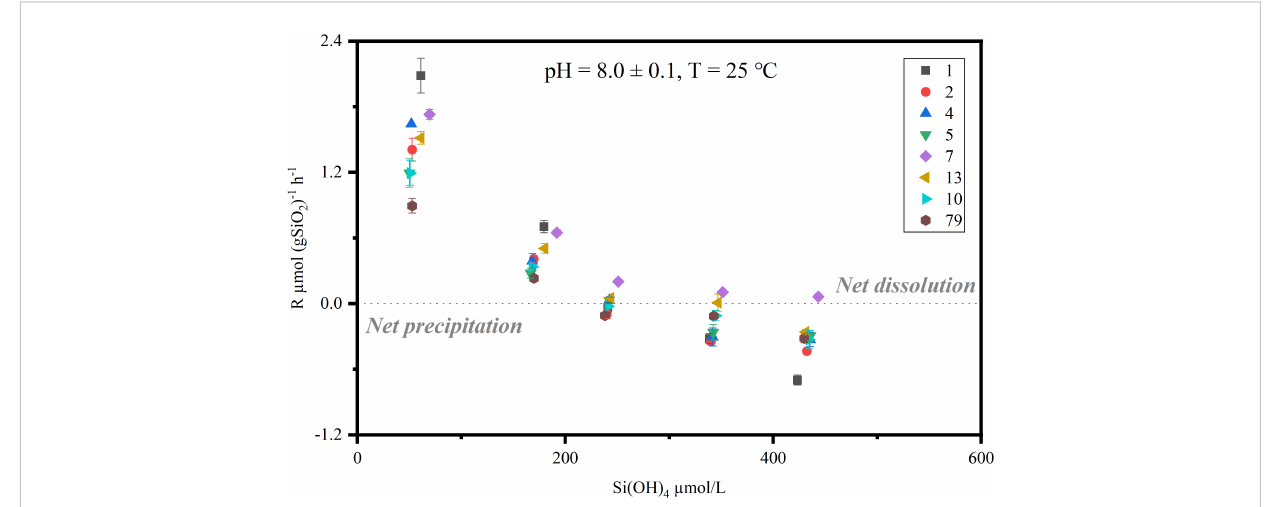
FIGURE 4 Steady state bSiO 2 dissolution-precipitation rates [ m mol (gSiO 2 ) -1 h -1 ] are plotted as a function of dSi out fl ow concentrations (T = 25 °C, pH = 8.0 ± 0.1) in surface sediments of the NSCS. Positive rates indicate net dissolution, and negative rates indicate net precipitation. The legends and numbers in the upper right corner indicate different stations conducted fl ow-through experiments. The uncertainties are shown by error